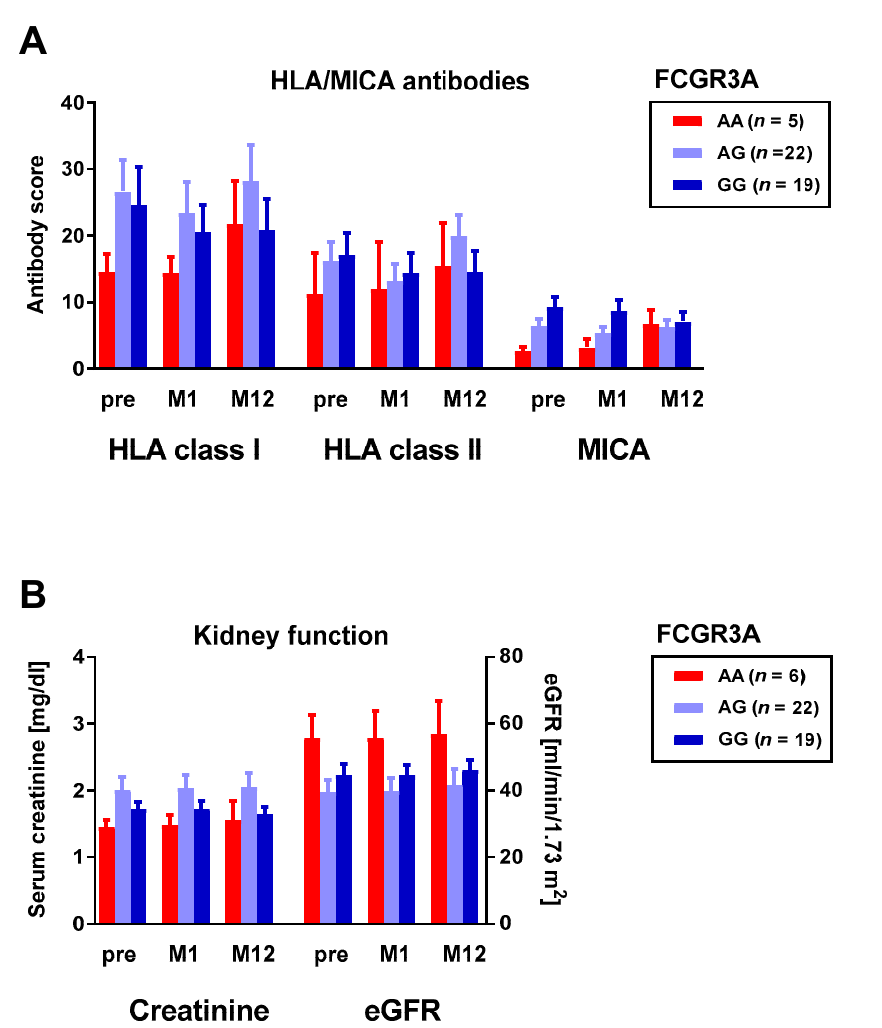
Figure 4. Kidney transplant recipients were genotyped for the FCGR3A rs396991 polymorphism and antibodies and kidney function were determined prior to pneumococcal vaccination (pre) and at month 1 (M1) and month 12 (M12) thereafter. Panel ( A ) shows antibodies against human leukocyte antigens (HLA) and major histocompatibility class I-related chain A (MICA). HLA/MICA antibodies were determined by Luminex™ technology. Responses to individual Luminex™ beads were summed up and an antibody score was generated, as detailed in Section 2. Panel ( B ) indicates serum creatinine concentration and estimated glomerular filtration rate (eGFR). The data represent means and standard errors of the mean (SEM).